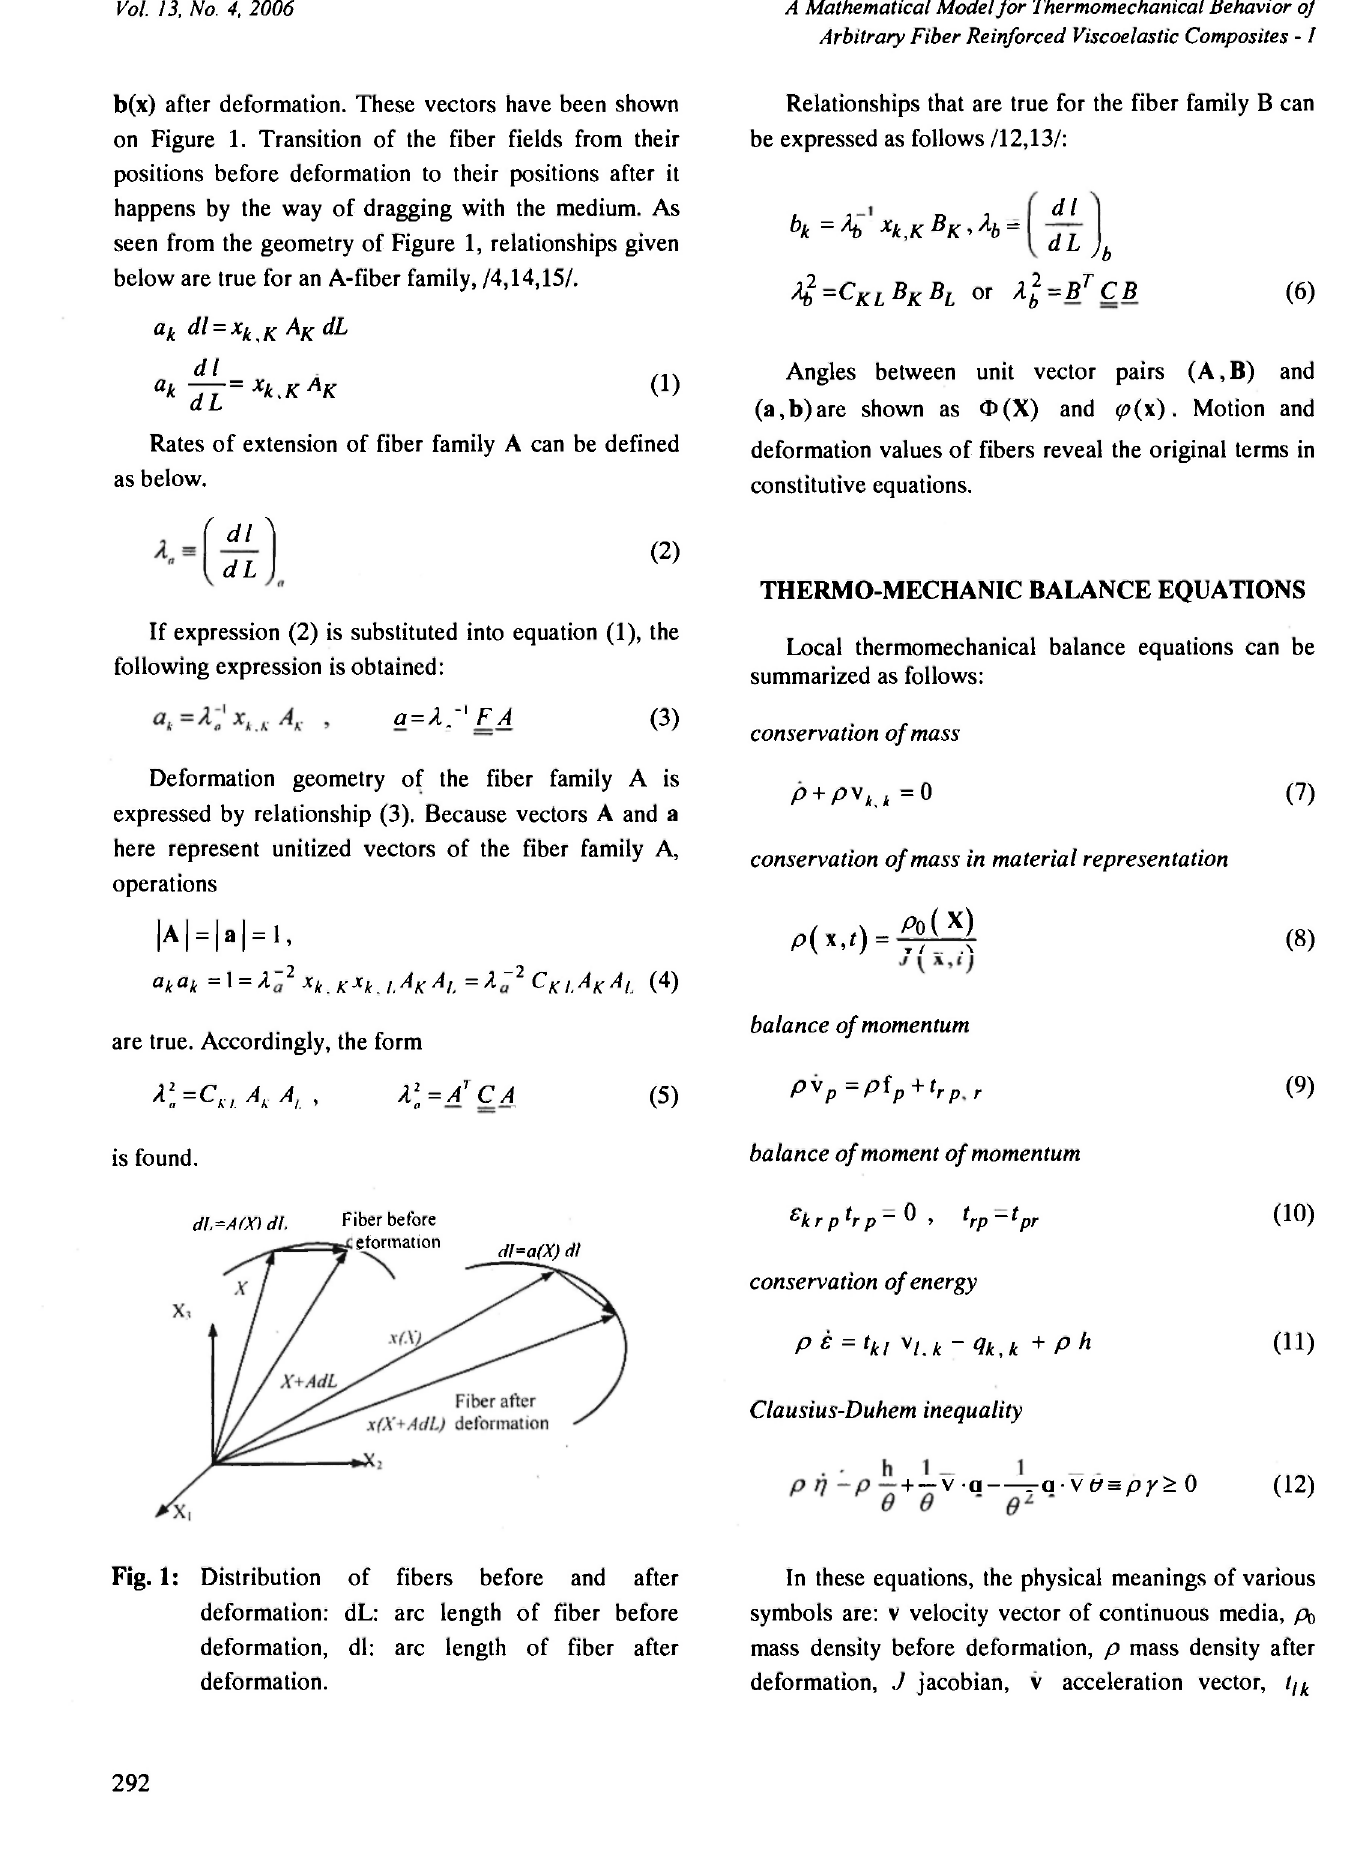
b(x) after deformation. These vectors have been shown on Figure 1. Transition of the fiber fields from their positions before deformation to their positions after it happens by the way of dragging with the medium. As seen from the geometry of Figure 1, relationships given below are true for an Α-fiber family, /4,14,15/.